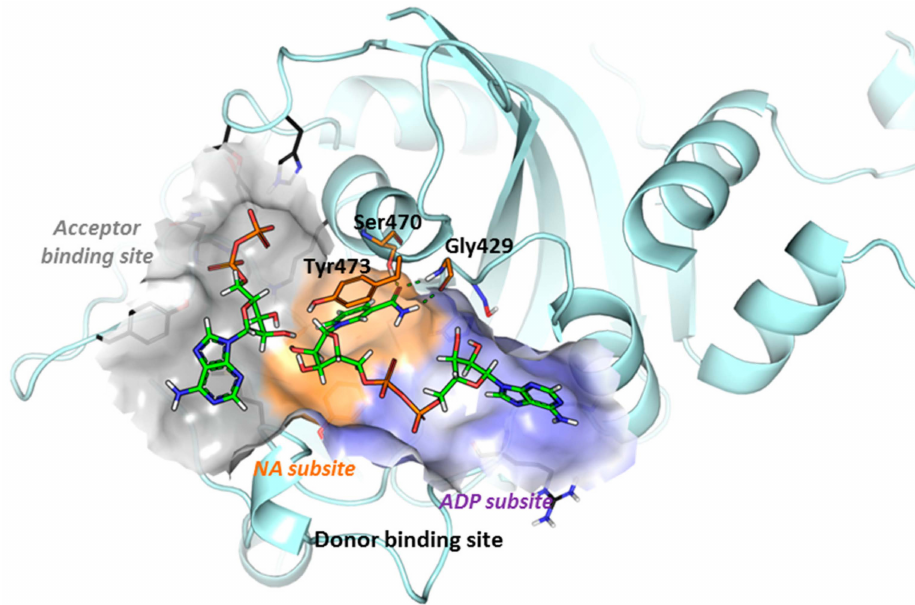
Figure 5. Structural model of the PARP-2 catalytic domain in complex with NAD + at the donor binding site and ADP fragment at the acceptor binding site. The molecular surface illustrates ADP binding subsites of acceptor substrate (gray color), nicotinamide riboside fragment of donor NAD + substrate (orange color) and the ADP fragment of donor NAD + substrate (blue color). HD domain is not shown for simplicity. Substrates are shown in green color.